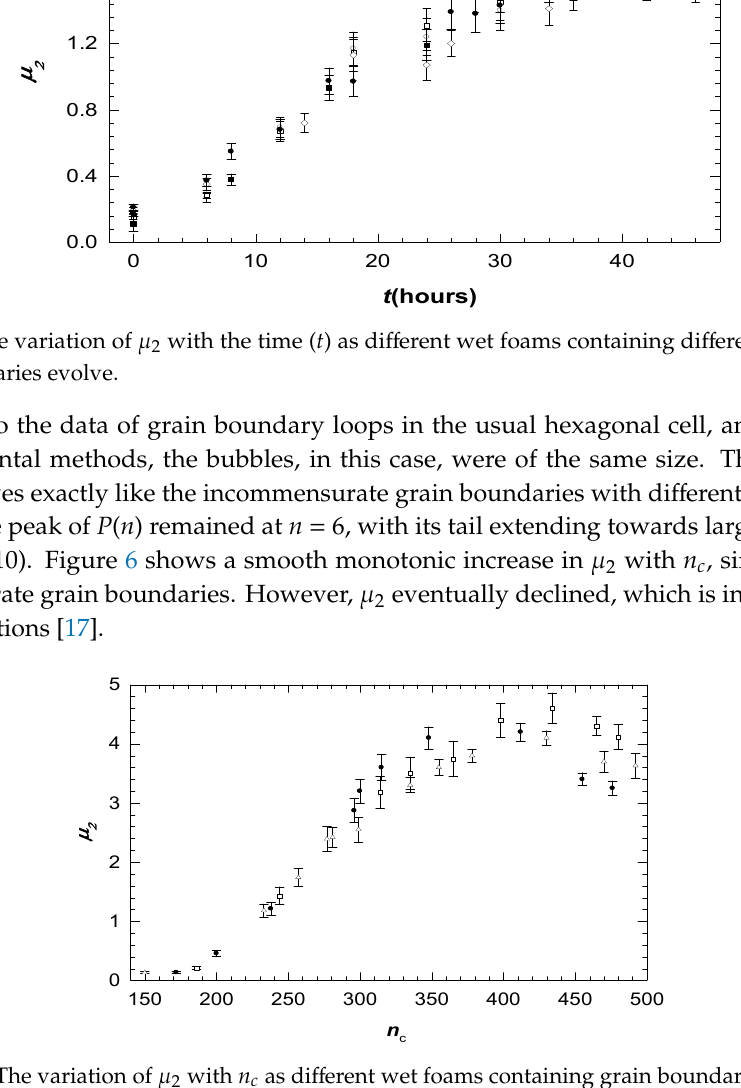
Figure 6. The variation of μ 2 with n c as different wet foams containing grain boundaries evolve.